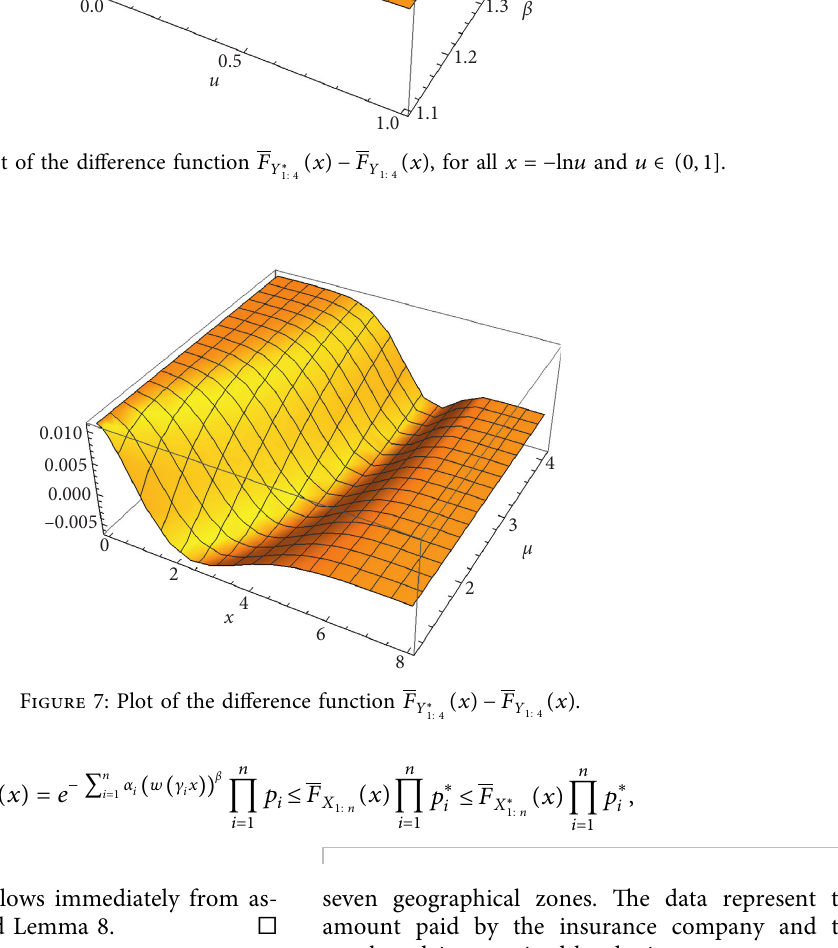
Figure 7: Plot of the difference function F